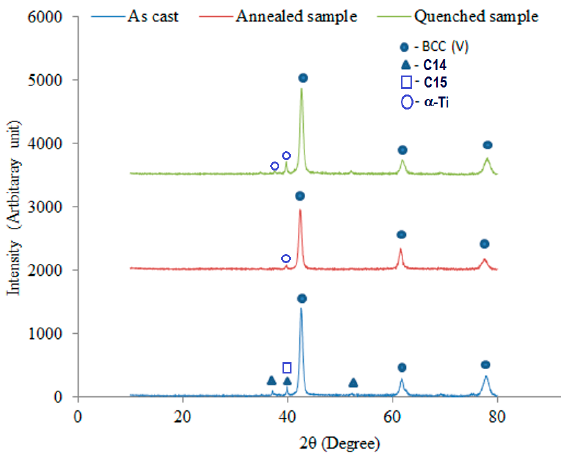
Figure 1. XRD patterns of the as-cast and heat-treated Ti 34 V 40 Cr 24 Fe 2 alloys.